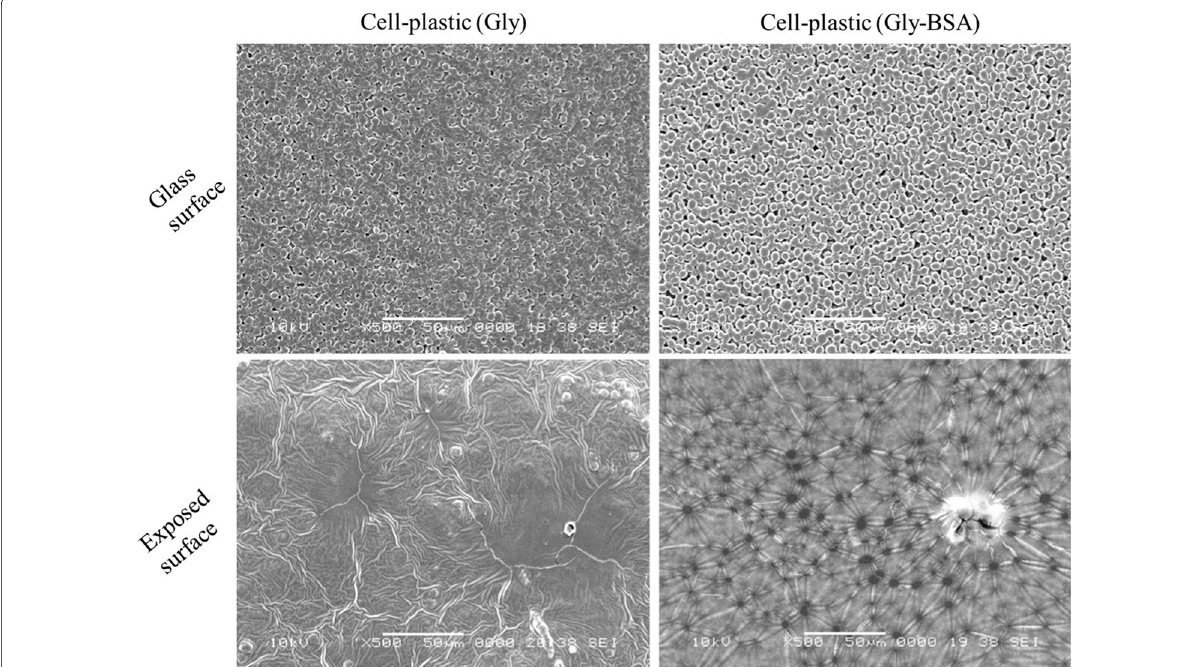
Fig. 7 SEM images of surfaces of cell-plastic (Gly) and cell-plastic (Gly-BSA) SEM images of surfaces of cell-plastic (Gly) and cell-plastic (Gly-BSA) on left and right column, respectively. Additionally, SEM images of different surfaces are shown (upper row: glass surface; lower row: exposed surface). All magnifications were ×